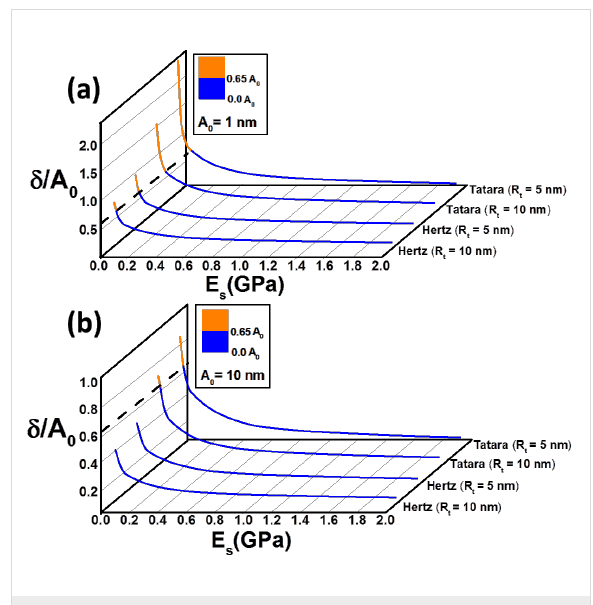
Figure 4: Normalized indentation as a function of the Young modulus of the sample for the Hertz and Tatara models. The indentation was normalized to the set-point amplitude: (a) A 0 = 1 nm and (b) A 0 = 10 nm. In the data above the dashed line indicates the point from which the whole oscillation is performed in contact to the material. Simulation inputs: k = 0.1 N/m, f 0 = 25 kHz, Q = 2, A sp = 0.65 A 0 , R s = 4 nm, and two different R t of 5 and 10 nm,